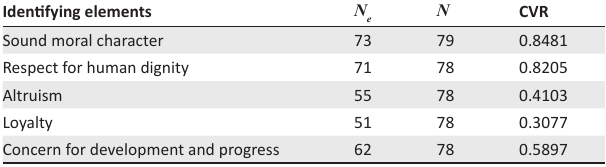
TABLE 4: Content Validity Ratio (Lawshe) of basic personal values of